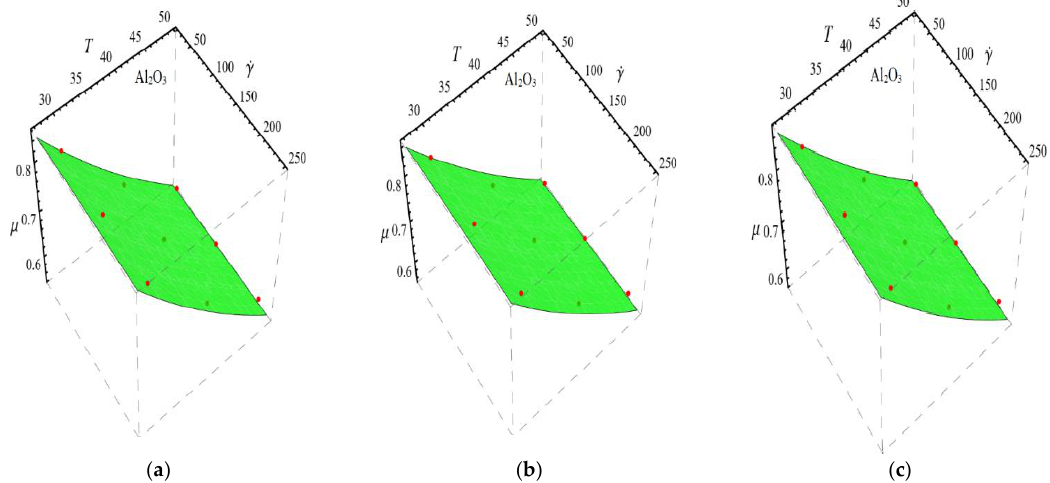
Figure 2. Fitting the Equation (2) for experimental data of Al 2 O 3 /DIW nanofluid at different nanopar- ticle volume fractions ( a ) φ = 0.025%, ( b ) φ = 0.05% and ( c ) φ = 0.075%.